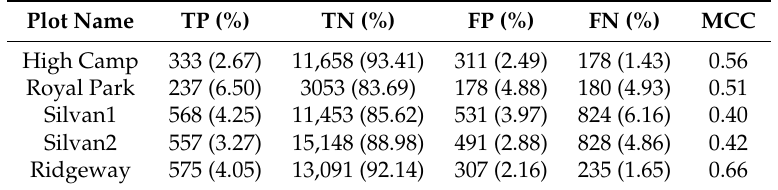
Table 2. Summary of confusion matrix results between SfM Non-normalised point cloud and validation frame data. For each plot, True Positives (TP), True Negatives (TN), False Positives (FP), False Negatives (FN) and Matthews Correlation Coefficient (MCC) are given.